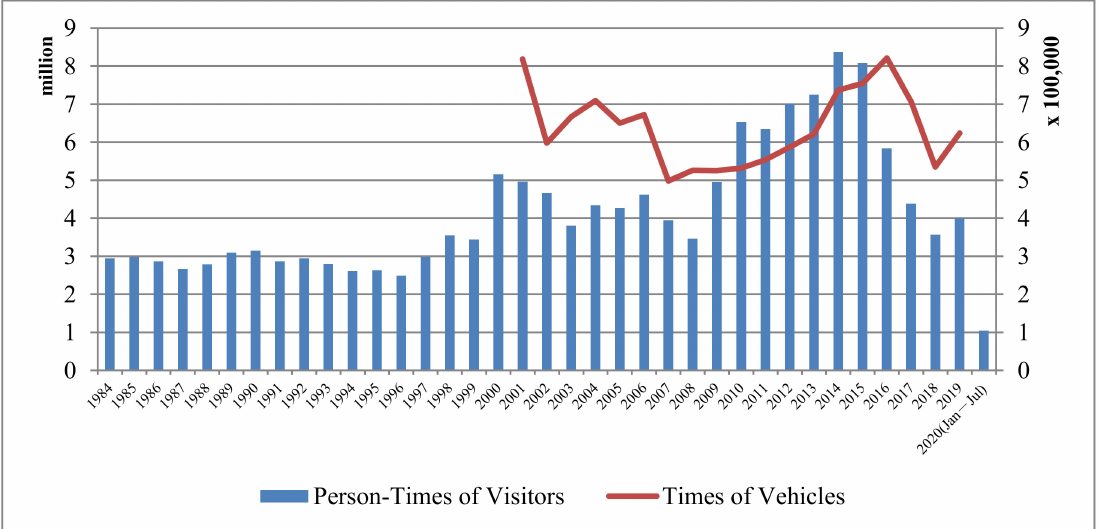
Figure 4. Visitor and vehicle numbers in Kenting National Park from 1983 to 2020 (January–July) and 2001 to 2019. (Note: data from https://www.ktnp.gov.tw/ (accessed on 8 August 2022), and Ministry of the Interior, R.O.C. (Taiwan) (accessed on 8 August